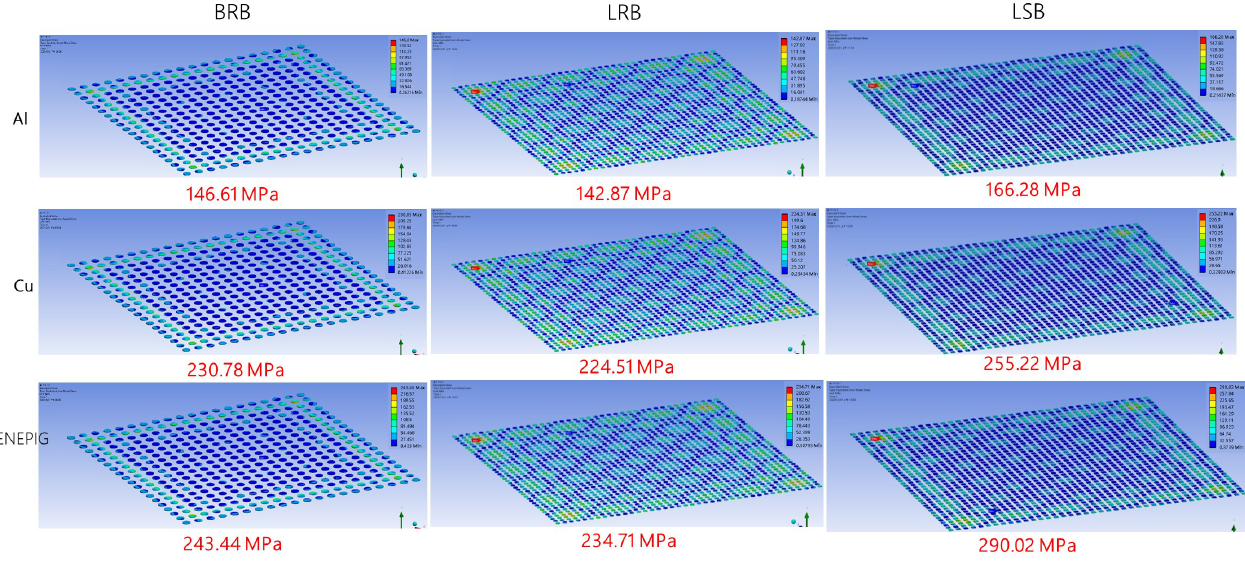
Figure 8. Stress distributions at the bonding interface when bump thickness was 5 µ m.